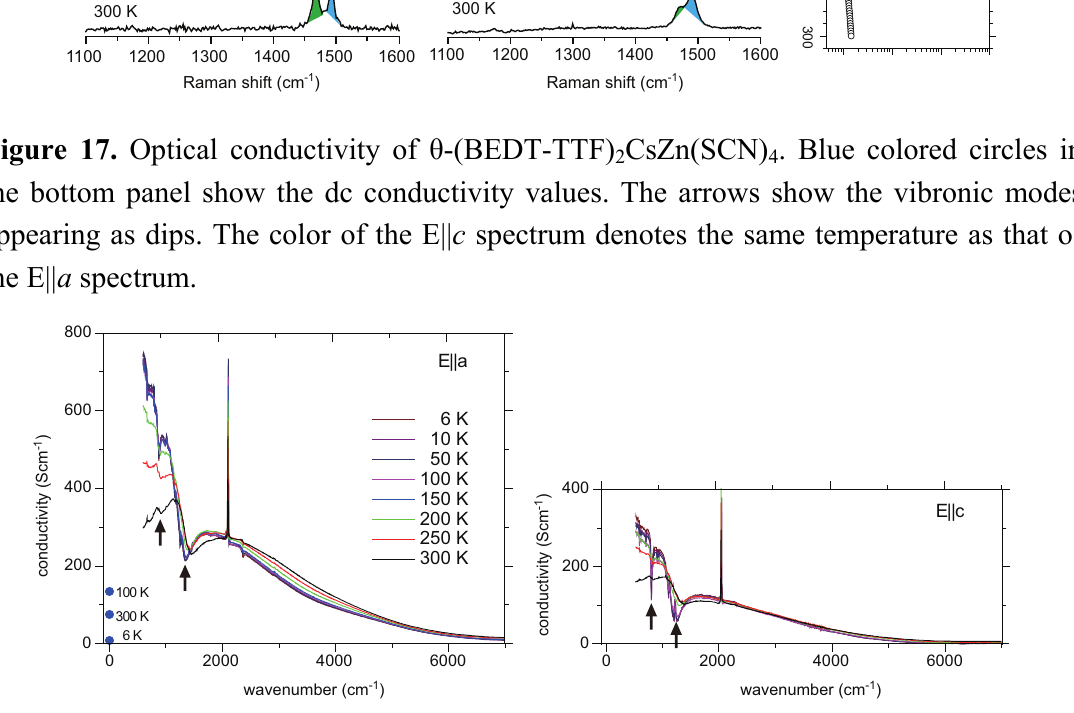
CsZn(SCN) . Blue colored circles in 2 4